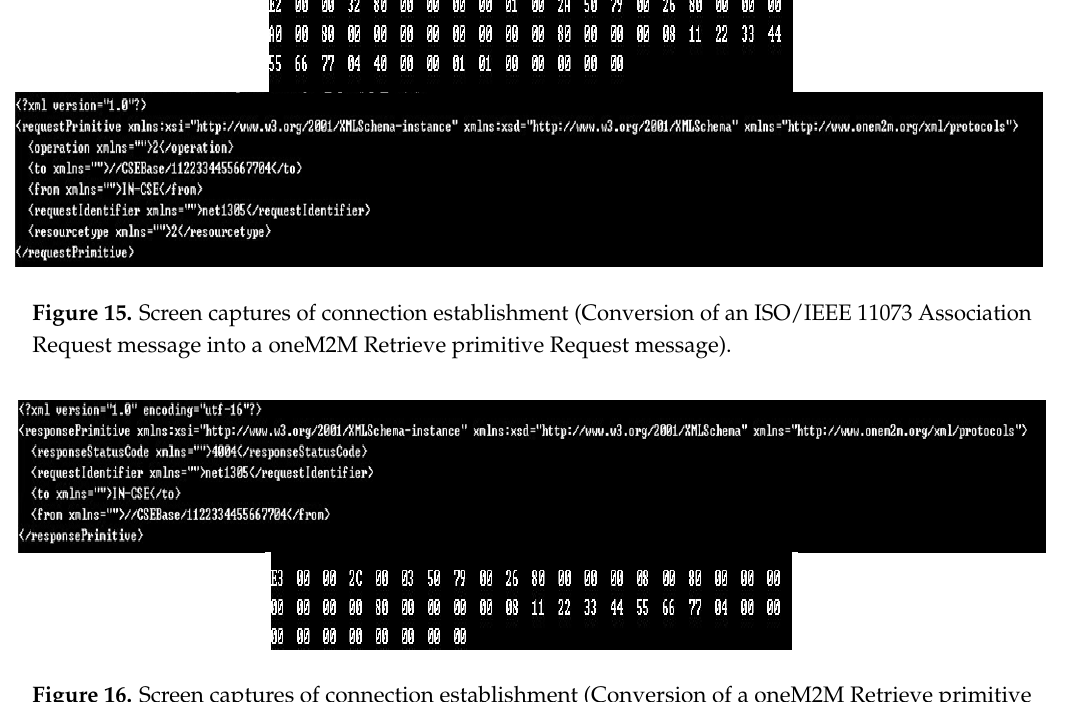
Figure 17. Screen captures of registration (Conversion of an ISO/IEEE 11073 Present (Notice Configuration) Request message into a oneM2M Create primitive Request message).